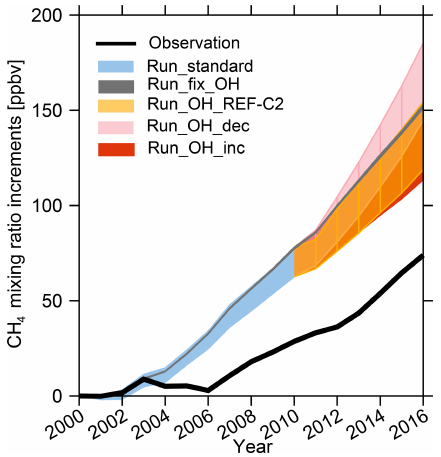
Figure 8. Time series of surface CH 4 mixing ratio increments compared to 2000 for NOAA observations (black line) and model ranges from all the LMDz experiments collected at observation sites (shades) and described in the text and in Table